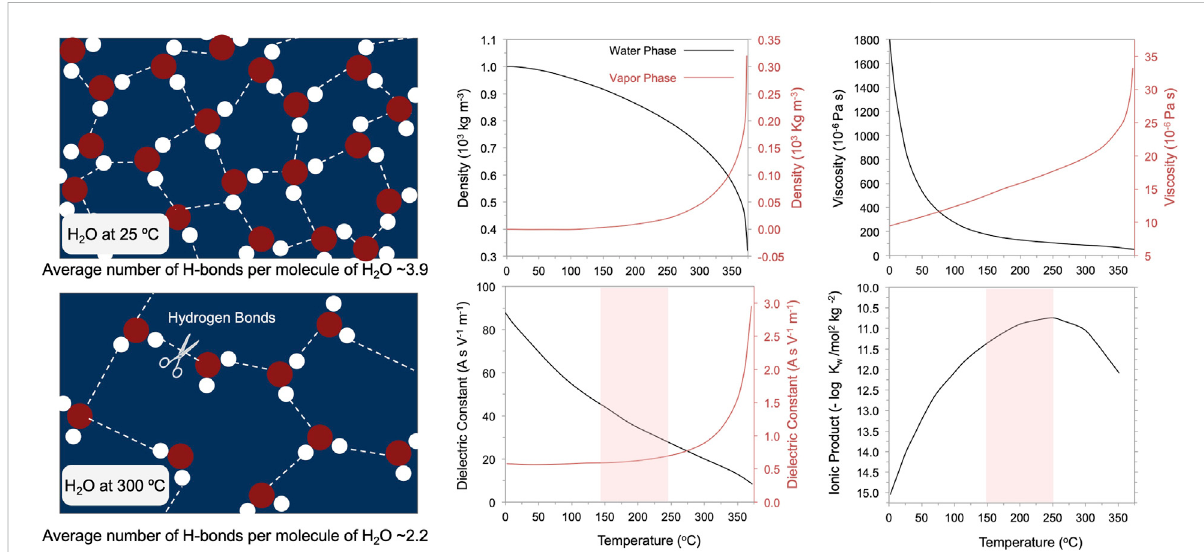
FIGURE 8 The change of the physicochemical properties of liquid water (black curve) and water vapor (red curve) as a function of temperature. Density andviscosityofliquidwaterdecreasewithtemperatureasthenumberofhydrogenbondspermoleculeofwaterdecreasesfrom3.9 at25 ° Cto2.2 at 300 ° C.Theionicproduct,K w ,reachesitsmaximumbetween150 ° Cand250 ° C(lightredzone)whenthedielectricconstant, ε ,reachesvaluesthatare typical of organic solvents, namely methanol and ethanol (from Unterlass, 2017 modi fi ed ). Data are from Sengers and Watson (1986) and Uematsu and Frank